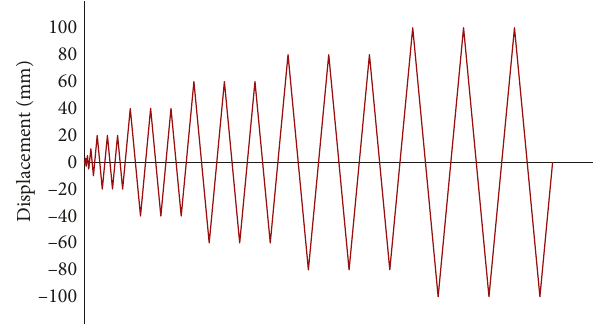
Figure 6: Test loading